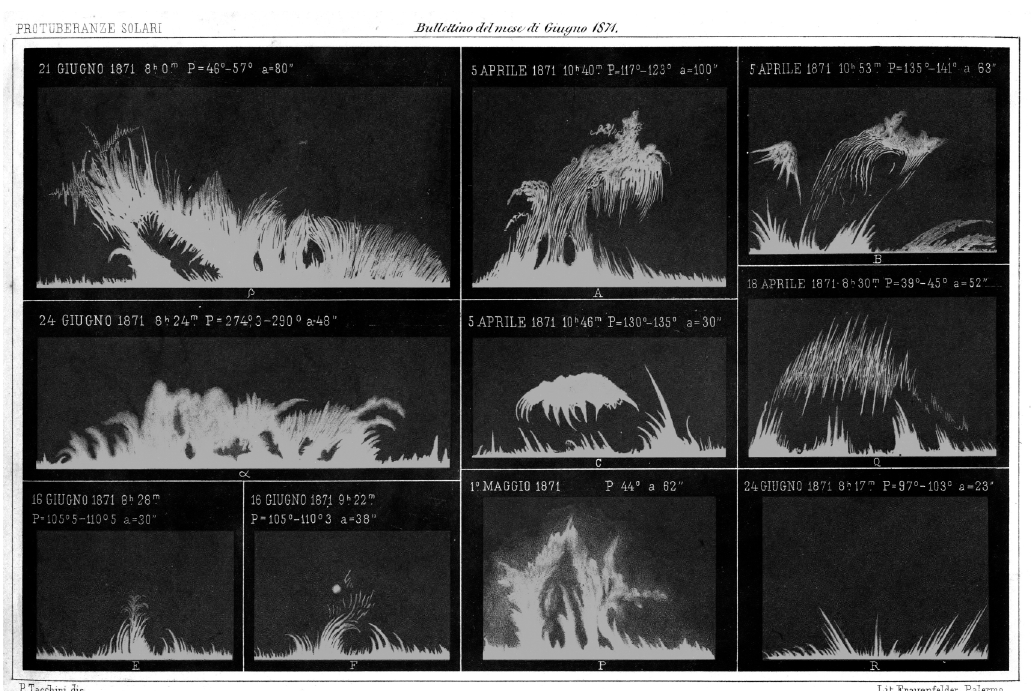
Fig. 2. Solar prominences drawn by Tacchini in